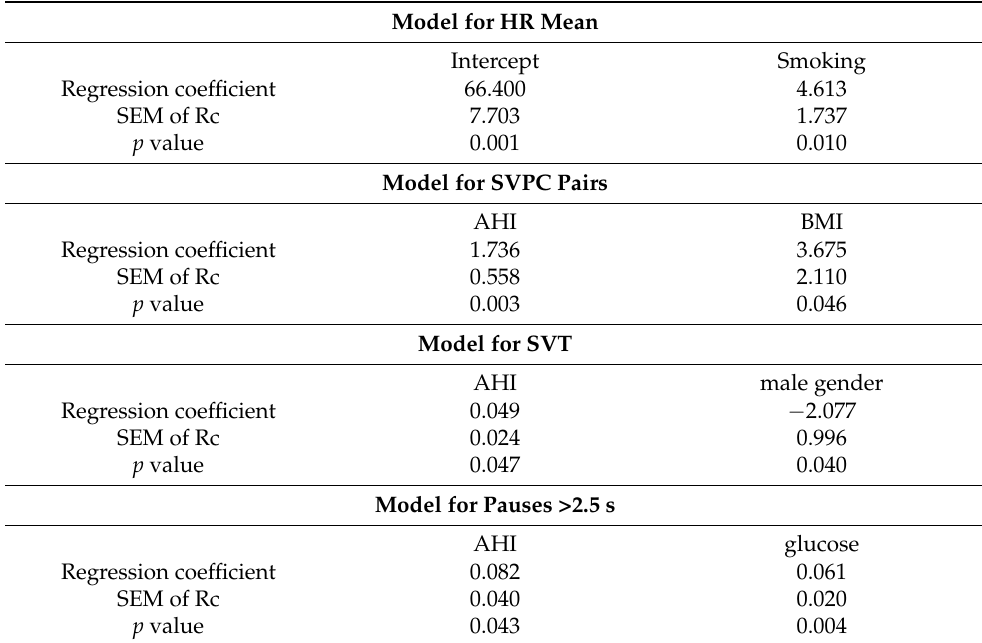
Table 6. Results of the regression analysis in the studied group of